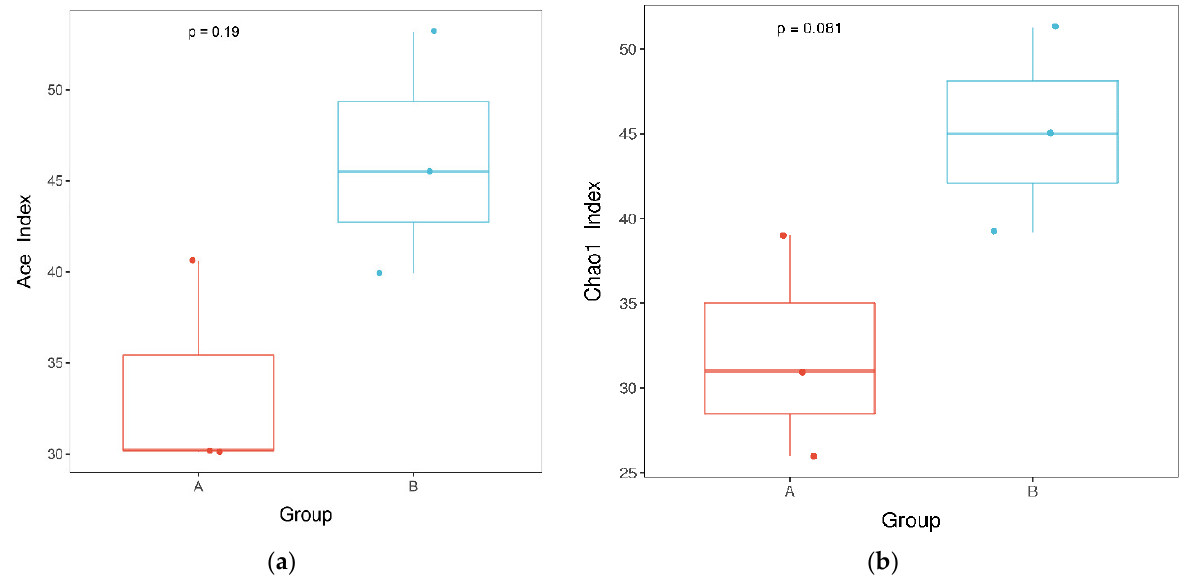
Figure 2. Fungal community structure in post-storage mildewed and unmildewed sunflower seed kernels. ( a ) Normal; ( b ) Mildewed. Note: Percentage was the mean value over three years (2018–2020).